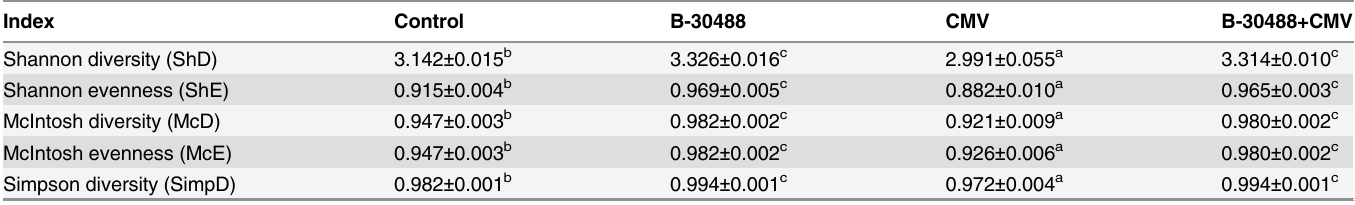
Table 2. Diversity and Evenness index of tobacco rhizosphere treated with B-30488, CMV and B-30488+CMV, based on substrate utilization pat- tern Biolog Eco plates containing 31 different carbon